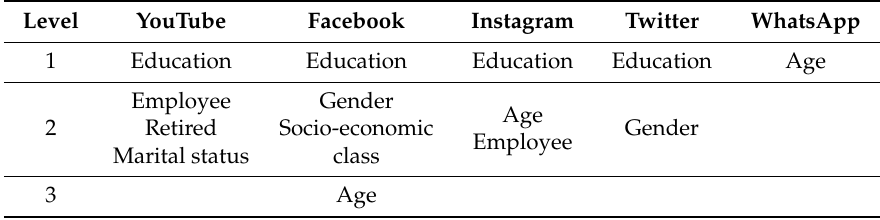
Table 16. Independent variables by level in the decision trees that explain the use of